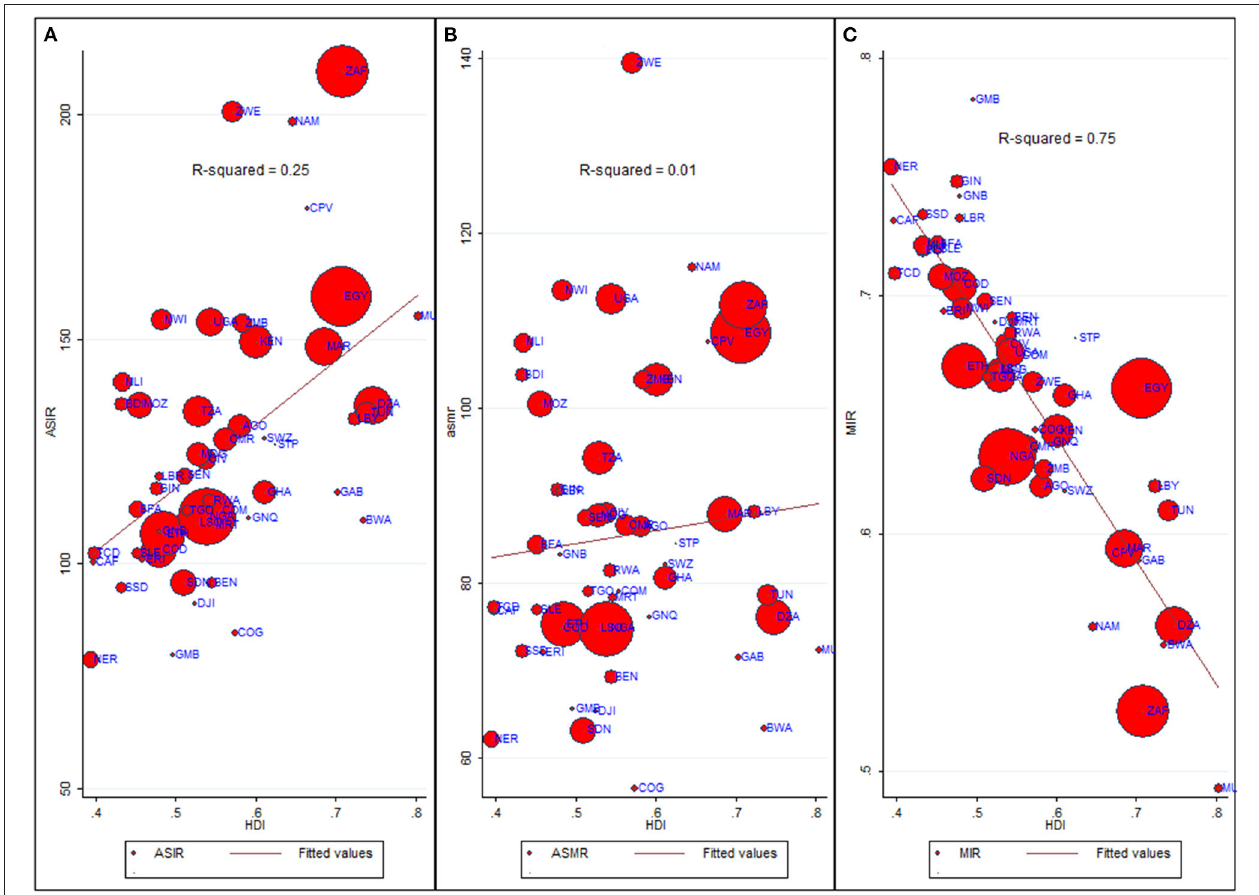
FIGURE 5 | Bivariate relationship between Age-standardized rates, MIR and HDI. ASIR, Age-standardized incidence rate (cases per 100,000); ASMR, Age-standardized mortality rate (deaths per 100,000); MIR, Mortality-to-Incidence Ratio; HDI, Human Development Index. Data source: GLOBOCAN 2020 (International Agency for Research on Cancer). The dots on scatter plot are inflated as per respective ASIR and marked as per country’s ISO-3 code. The data of HDI is procured from United Nations Development Program. (A) ASIR vs. HDI. (B) ASMR vs. HDI. (C) MIR vs.